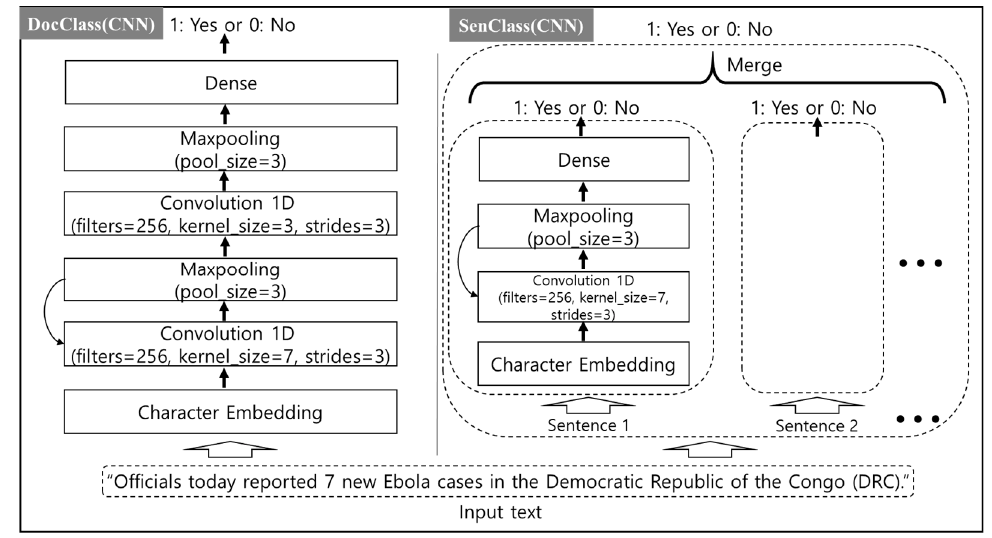
Figure 2. The ConvNet model structure for two classification methods, DocClass and SenClass. CNN: convolutional neural network.